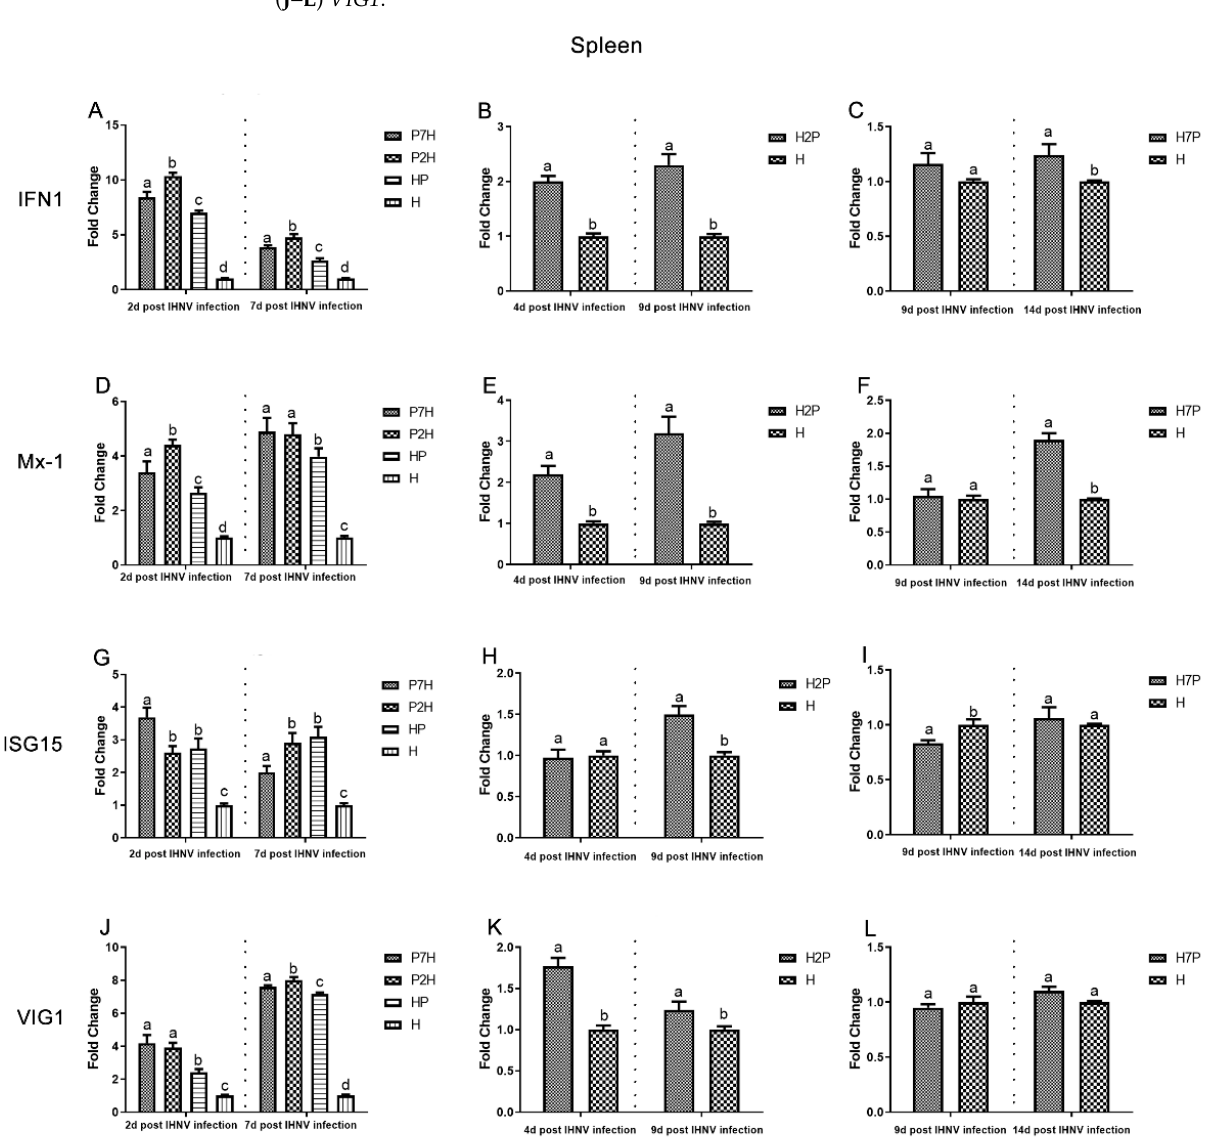
Figure 10. Gene expression of immune-related factors in the spleen based on qRT-PCR evaluation. Data represent relative values with respect to IFN1 , Mx-1 , ISG15 , and VIG1 gene expression. Different letters indicate statistically significant differences ( p < 0.05). ( A – C ) IFN1 ; ( D – F ) Mx-1 ; ( G – I ) ISG15 ; ( J – L ) VIG1 .